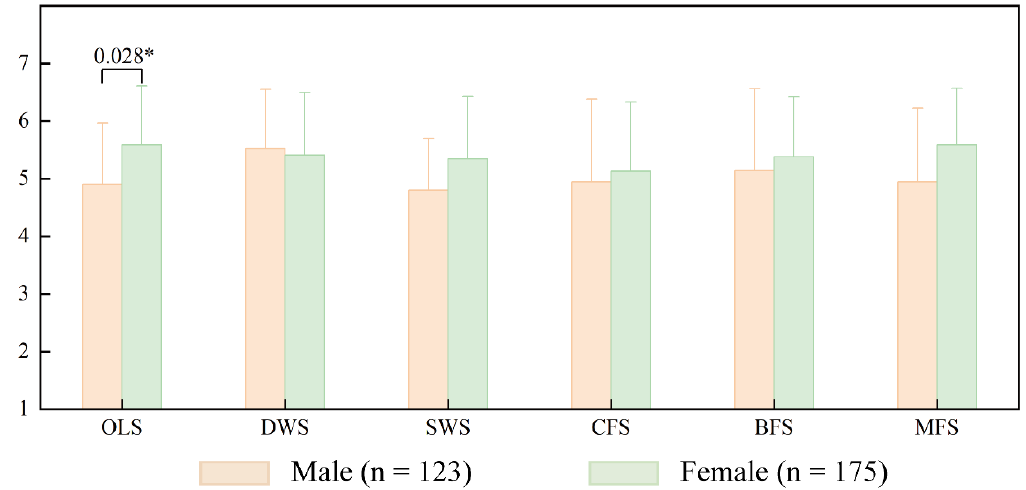
Figure 7. The comparison of the mean values of participants’ preference scores of the various forest landscape spaces. * p < 0.05. OLS: overlook landscape space ( n = 49); DWS: dynamic water landscape space ( n = 48); SWS: static water landscape space ( n = 51); CFS: coniferous forest landscape space ( n = 50); BFS: broadleaf forest landscape space ( n = 51); MFS: mixed forest landscape space ( n = 49).